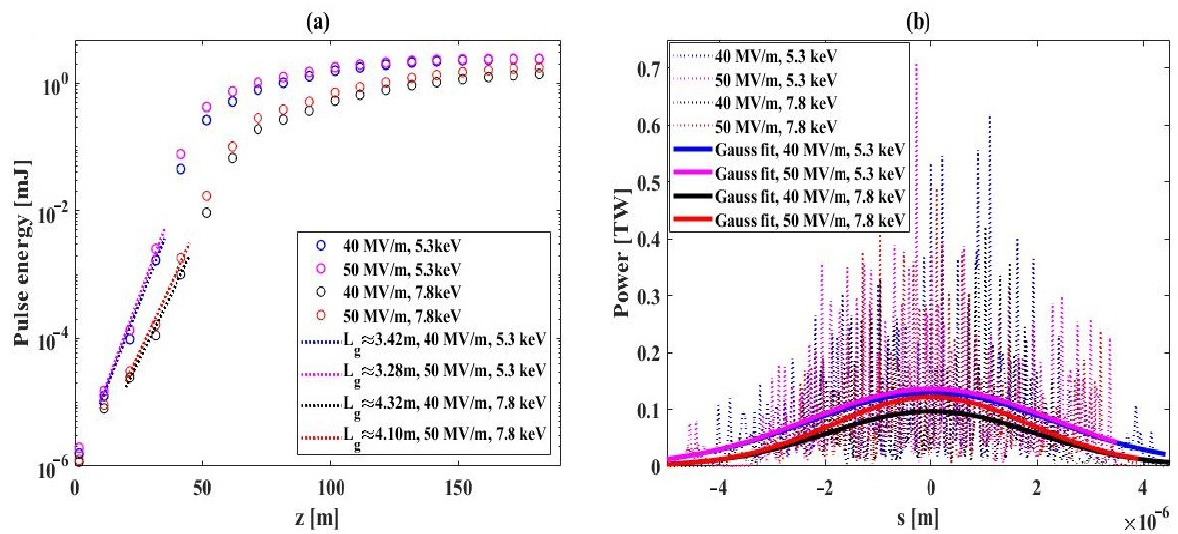
Figure 10. SASE performance of optimized 7.3 GeV electron bunches produced at lower cathode accelerating gradients of 40 MV/m and 50 MV/m for a potential CW operation at exemplary photon energies of 5.3 keV and 7.8 keV. ( a ) gain curves; ( b ) power distributions by the end of the undulator beamline. Dashed lines in ( a ): exponential fits to the gain curves. Solid lines in ( b ): Gaussian fits to the power